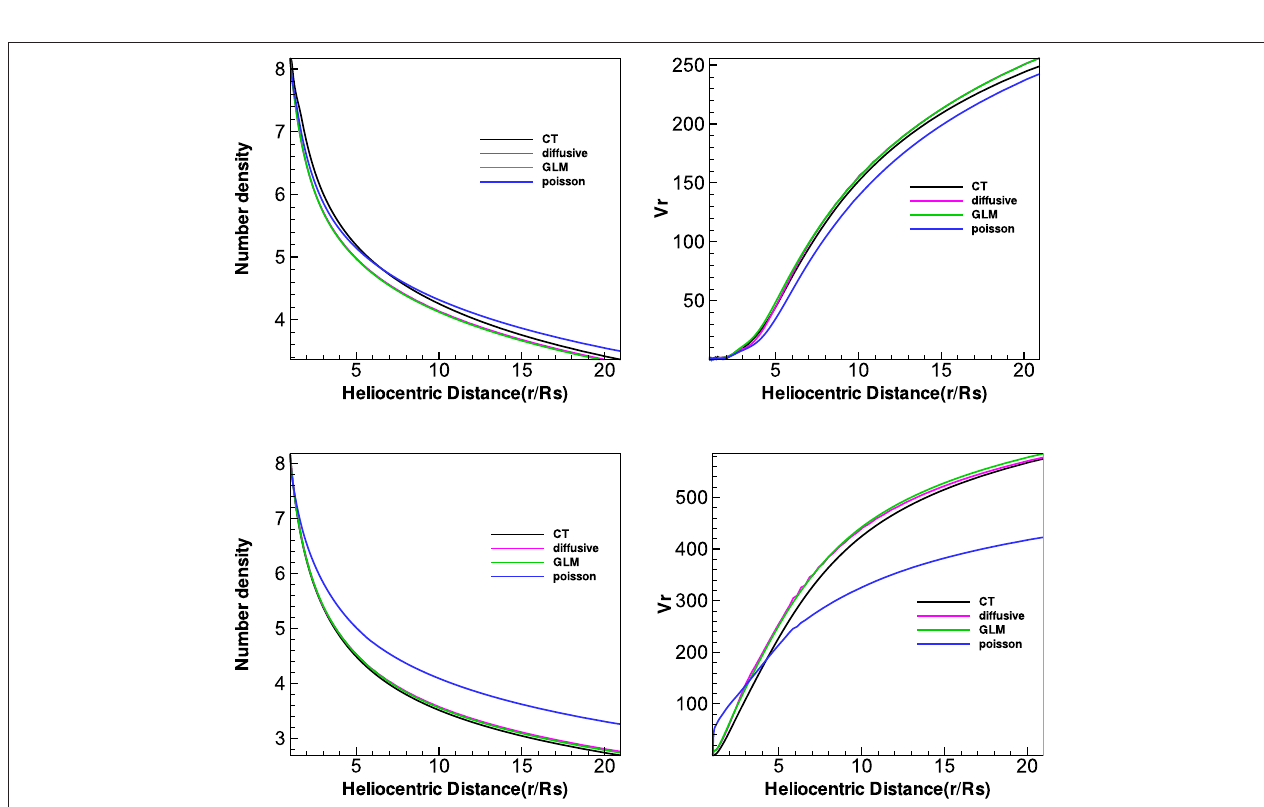
FIGURE 6 | The number density N ( log 10 / cm 3 ) and radial speed v r (km/s) distribution along heliocentric distance with different latitudes θ = 100 ◦ (top) and θ = 174 ◦ (bottom) at the same longitude φ = 0 ◦ from the four divergence cleaning methods.